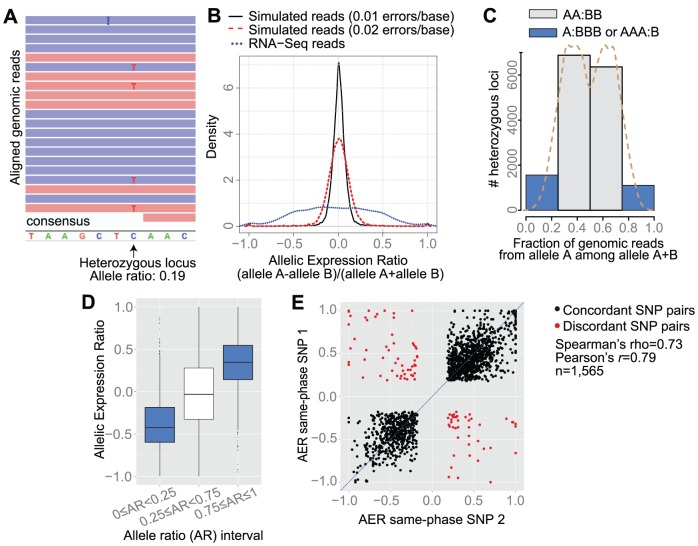
Analyses of allele-specific expression.(A) An example of a heterozygous locus identified from genomic Roche 454 reads (horizontal bars). Colors represent alignments in the forward and reverse directions. The arrow indicates a heterozygous locus. (B) Density plots of allelic expression ratios calculated from simulated reads and RNA-seq reads. The black and red lines correspond to simulated reads containing 0.01 and 0.02 errors/base. The blue line represents RNA-seq data (GS isolate). (C) Histogram of allele ratios (genomic) of heterozygous loci. The superimposed curve (brown) shows the density of the underlying data. The allele ratio was calculated from genomic reads as the fraction of allele A among allele A+B. Grey bars represent loci containing two presumed copies of each allele and blue bars three copies (or vice versa) of each allele. (D) Boxplots of allele expression ratios (y-axis) according to the allele ratio (x-axis). The black line of each box is the median. Dots represent outliers. (E) Allelic Expression Ratios of heterozygous loci of the same haplotype phase. Each dot represents one pair of linked heterozygous loci (SNP pairs). The allelic expression of SNPs 1 and 2 are shown on the x- and y-axes. Red dots indicate discordant heterozygous loci and black dots represent concordant heterozygous loci; i.e., the direction of gene expression change is the same.